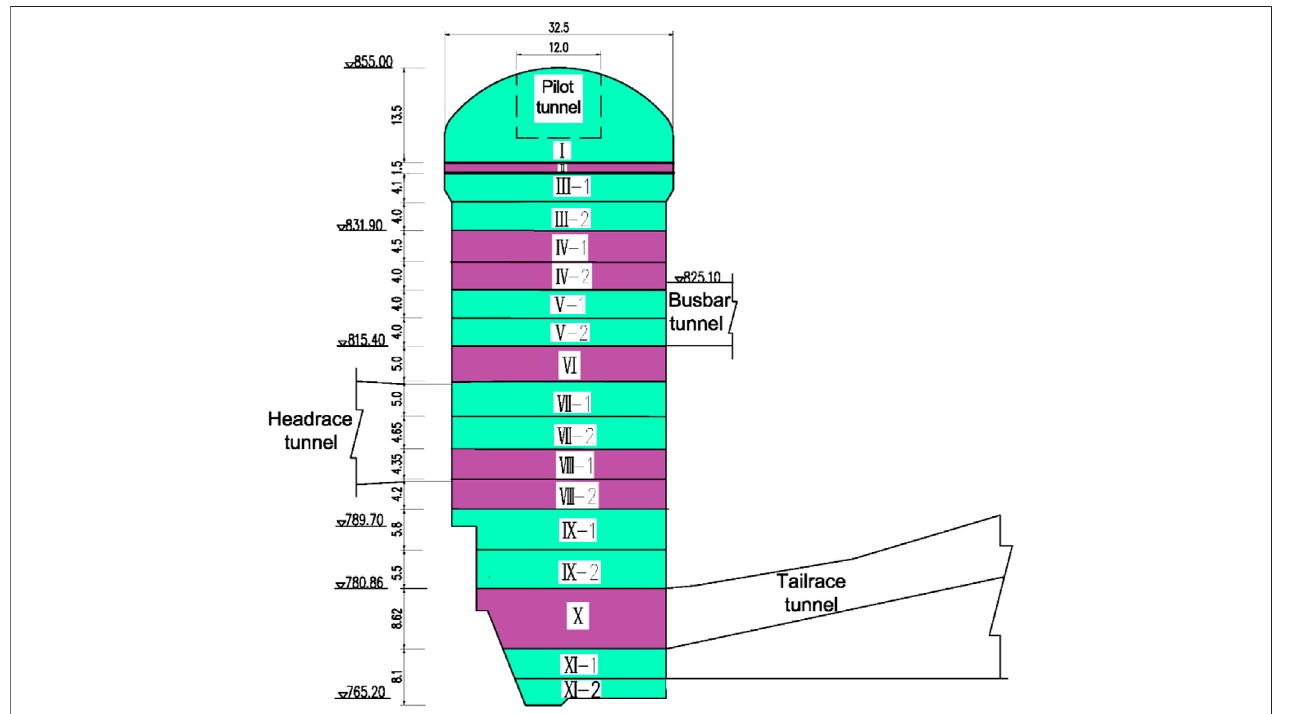
FIGURE 4 | Schematic view of the excavation sequence for the right bank powerhouse (Unit: m).